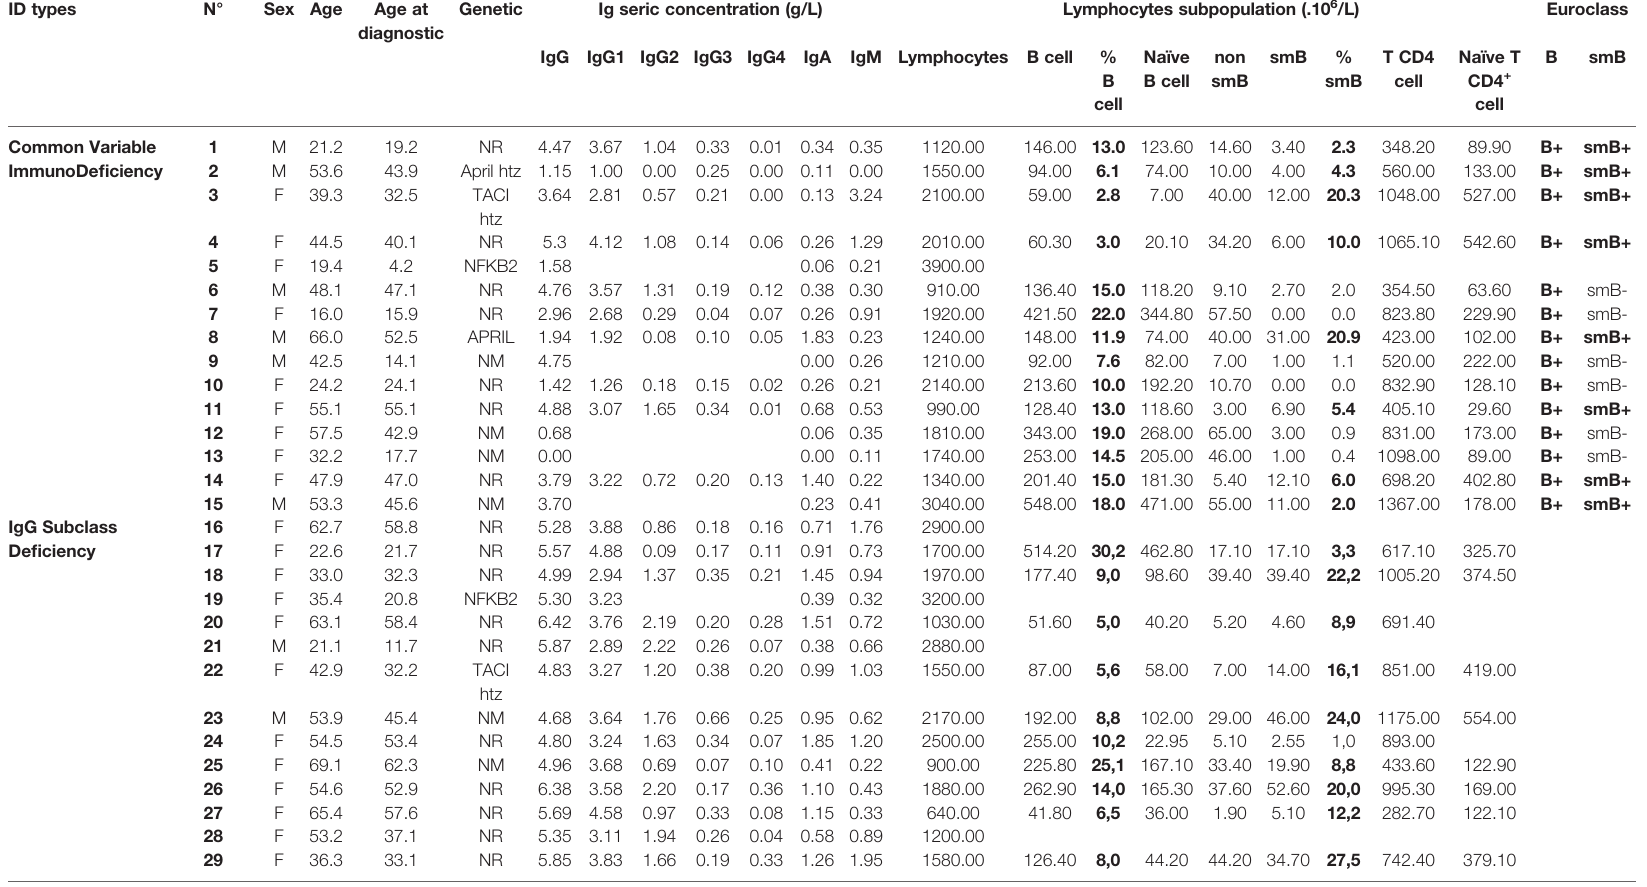
TABLE 1 | PID patients ’ demographical and immunological